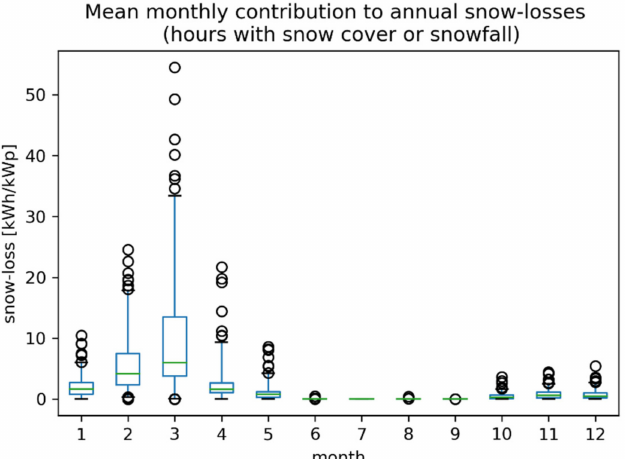
Figure 6. Boxplot for the mean of monthly contributions to the annual snow losses. Means are calculated for the sites with full winter season data ( n = 257) and on average two winters ( n = 542), with at least 90% data availability. Statistics presented in the plot are the median (green line), 50% (box), and 95% (whiskers) intervals as well as outliers